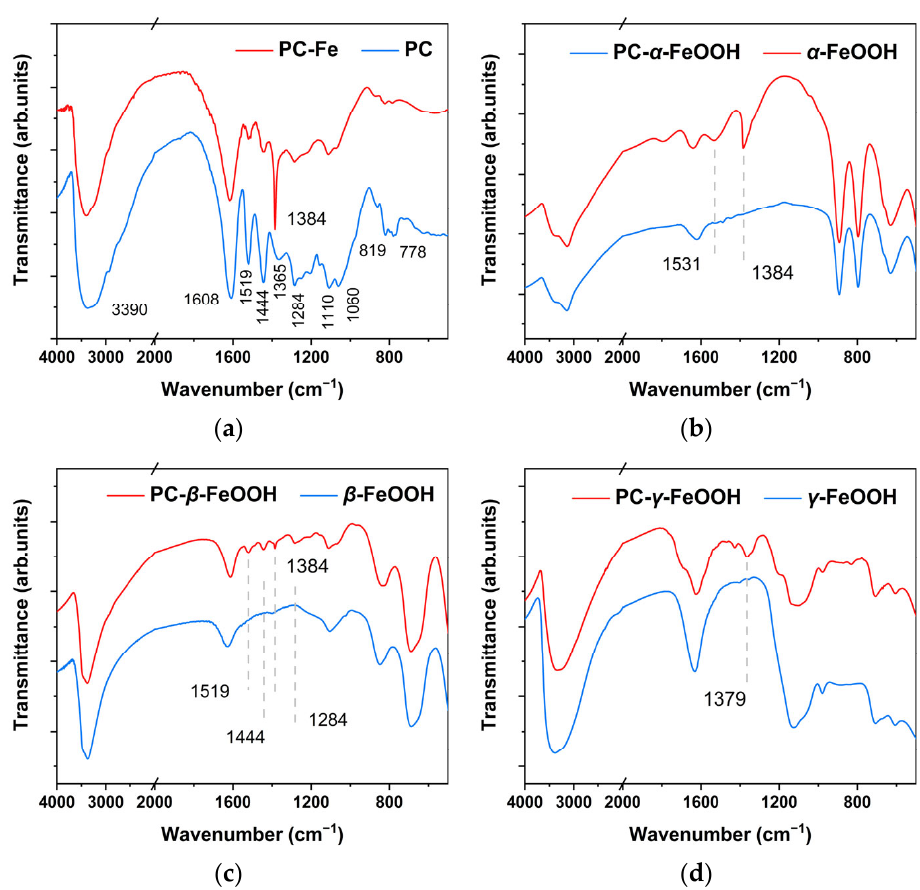
α -FeOOH ( b ), β -FeOOH ( c ) and γ -FeOOH ( d ) modified by Figure 9 . FTIR of original rust ( a ), α‐ FeOOH ( b ), β‐ FeOOH ( c ) and γ‐ FeOOH ( d ) modified by PC. Figure 9. FTIR of original rust ( a ),